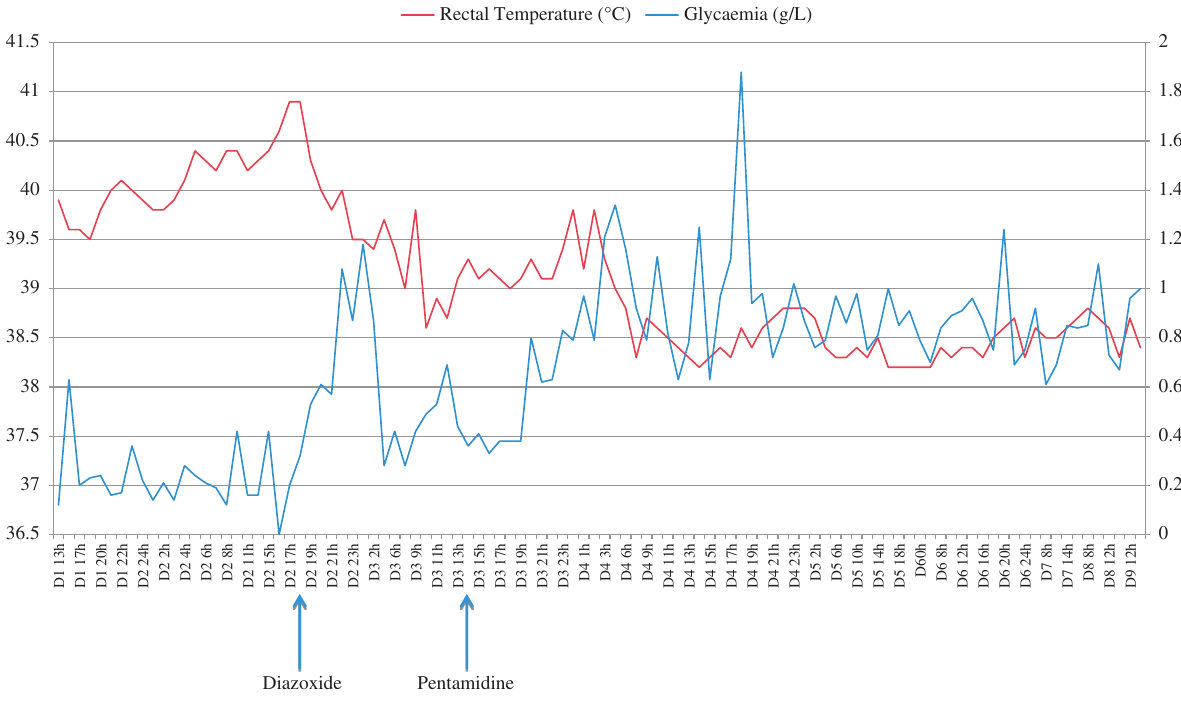
Figure 4. Temperature and glycaemia as a function of